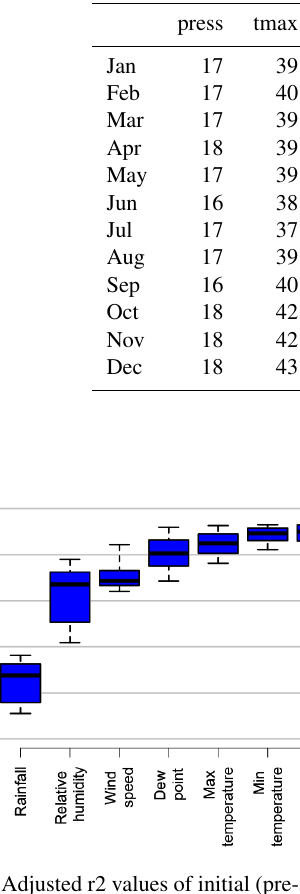
Figure 3. Adjusted r2 values of initial (pre-spline) regression mod- els. Each boxplot includes 12 points, 1 for each monthly model.